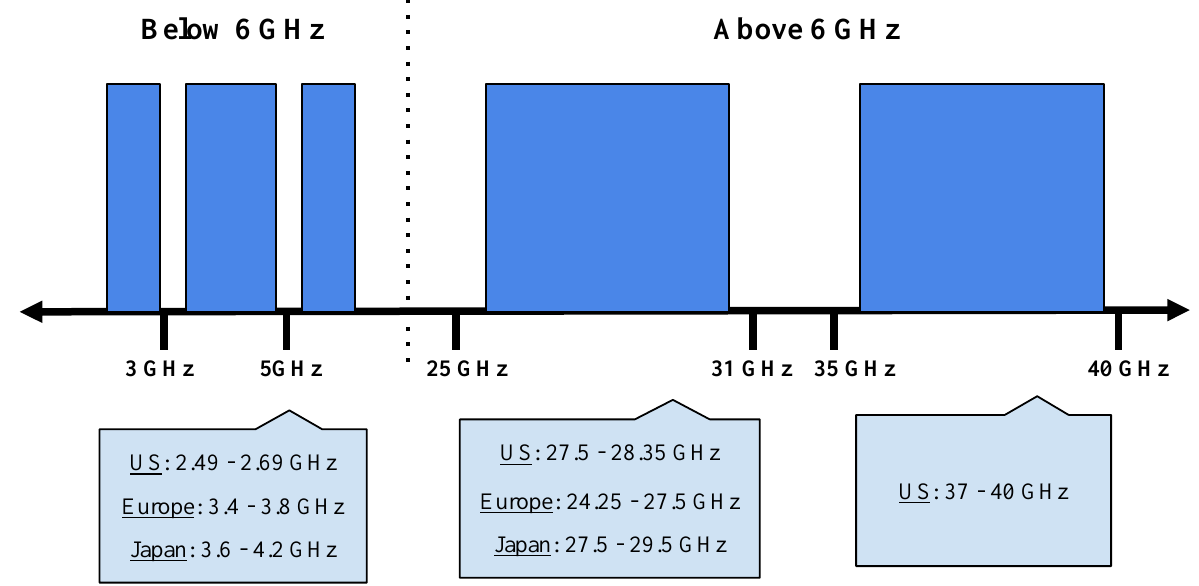
Figure 1. Overview of 5G Frequency